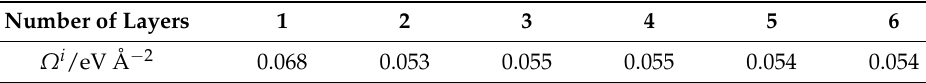
Table 2. Calculated surface energies for O|Zr|OO|Zr|O termination of c -ZrO 2 (111) surface at all O chemical potential.